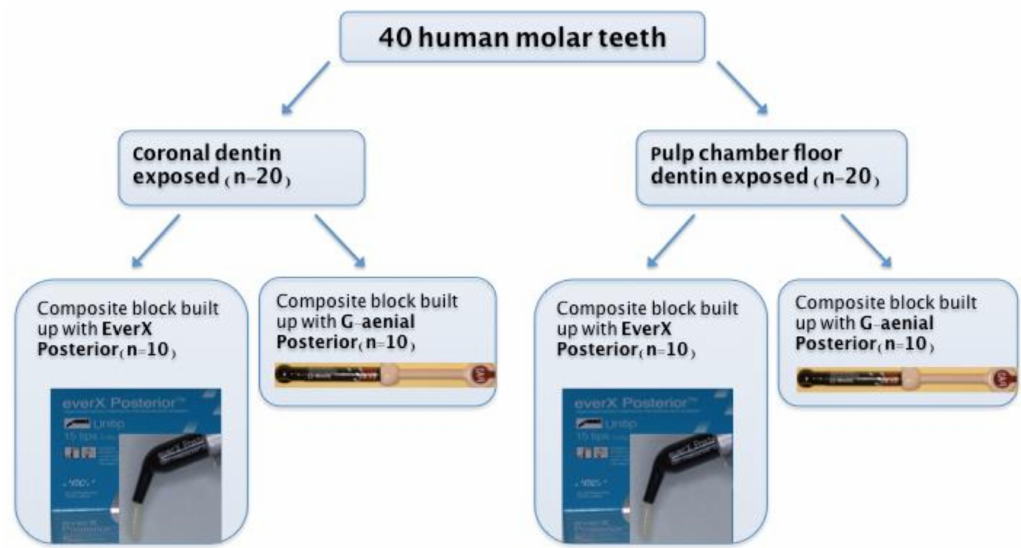
Figure 1. Experimental groups: 40 sound human molar teeth were divided into two groups according to the exposure of coronal dentin (n = 20) or pulp chamber floor dentin (n = 20). Each group was further divided into two subgroups depending on the material used for composite block build-up.